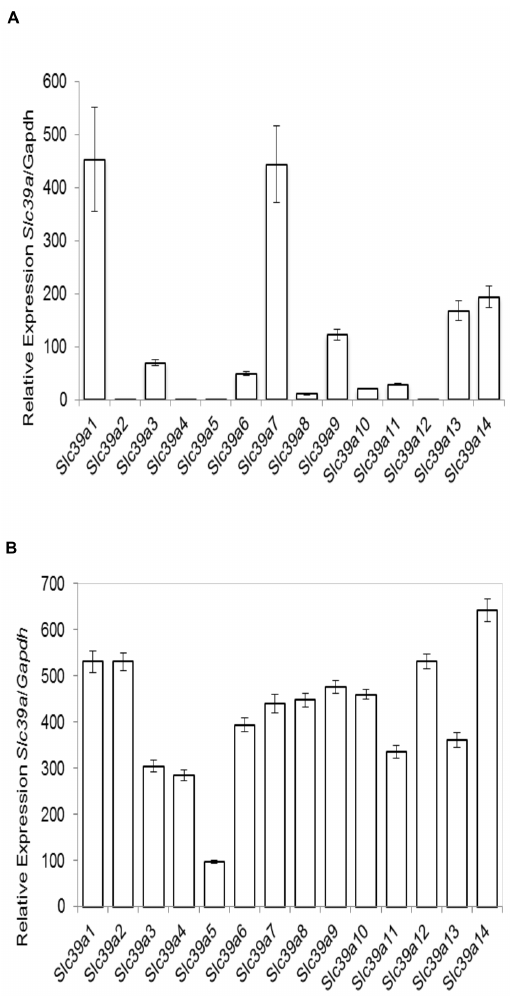
Figure 1. mRNA expression of the zinc transporters Slc39a (Zip) relative to the housekeeping gene, Gapdh in mouse C2C12 skeletal muscle cells and mouse quadriceps. A–B): Slc39a1-14 mRNA expression in C2C12 cells and mouse quadriceps, respectively. Error bars indicate 6 SD from three independent biological samples.